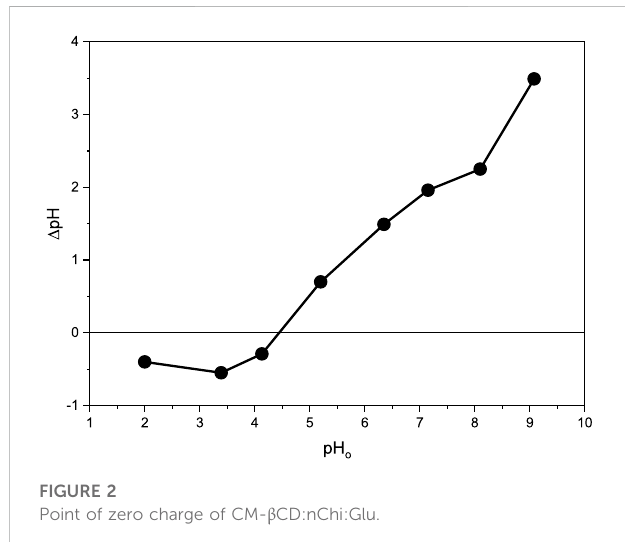
FIGURE 2 Point of zero charge of CM- β